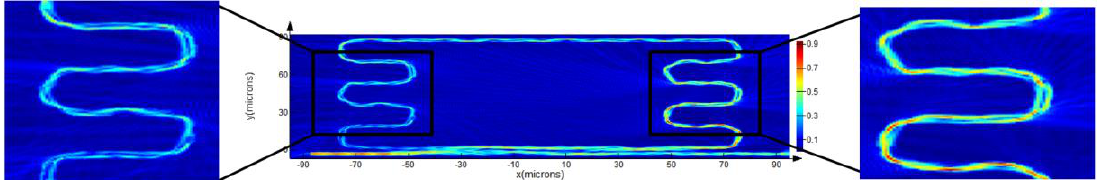
Figure 8. The E-field profile of S-bend resonator with N = 5 at λ = 1.55 μ m.